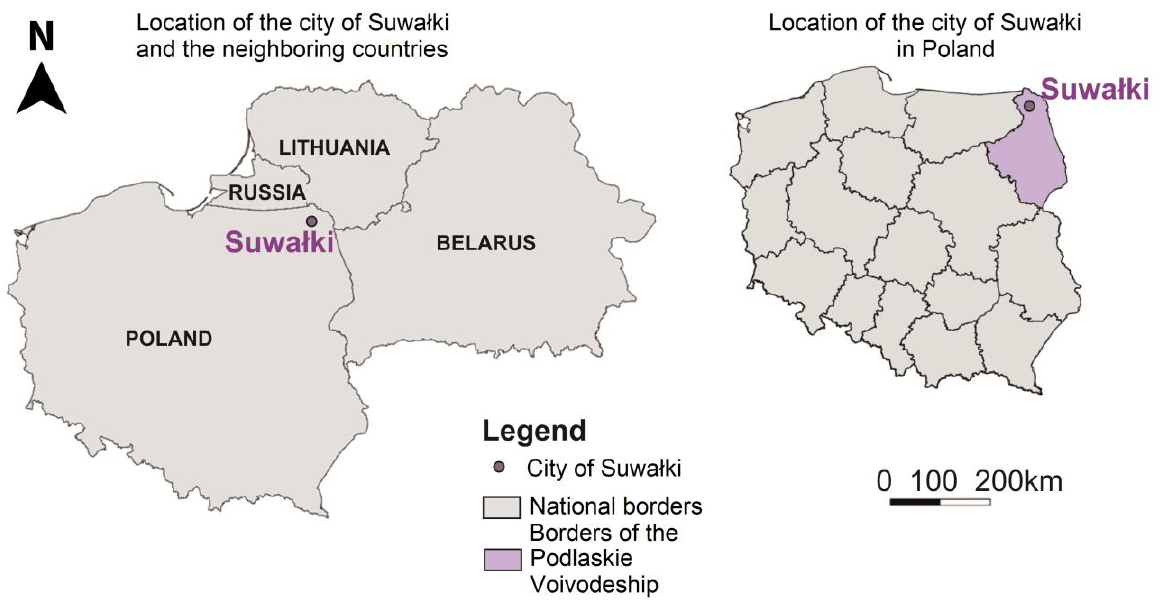
Figure 2. The location of the city of Suwałki compared to neighbouring countries and Poland. Source: own study.